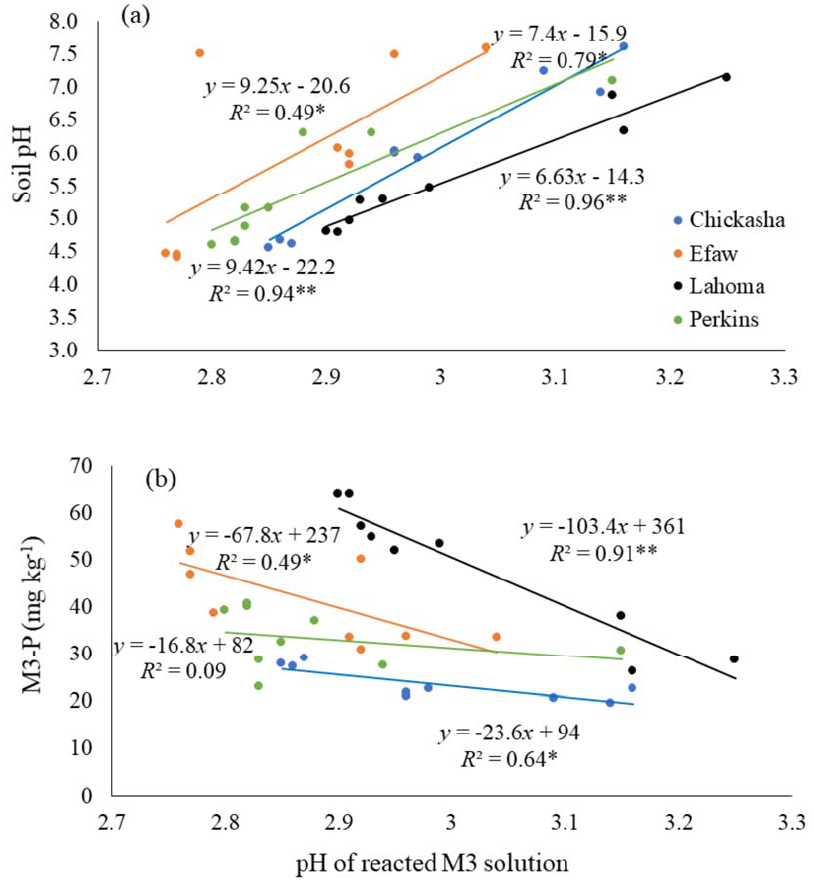
Figure 4. Relationship between the final pH of reacted Mehlich ‐ 3 (M3) solution and soil pH ( a ) and M3 phosphorus (M3 ‐ P) concentration ( b ). *,**, indicate statistical significance at p < 0.05 and 0.01, respectively.